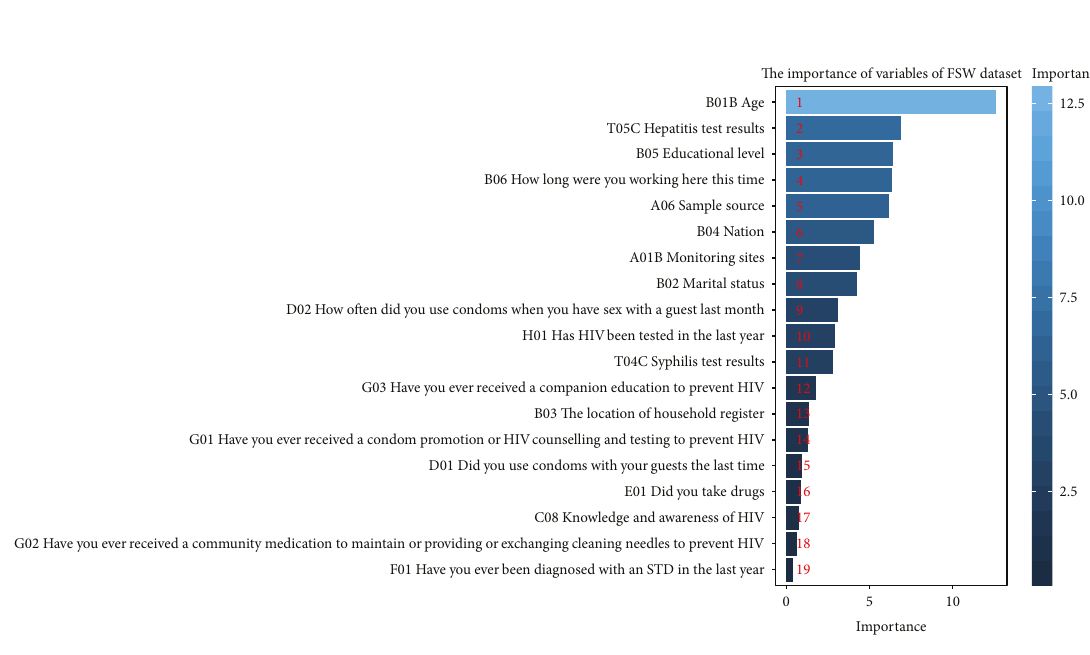
Figure 2: The importance of variables of FSW